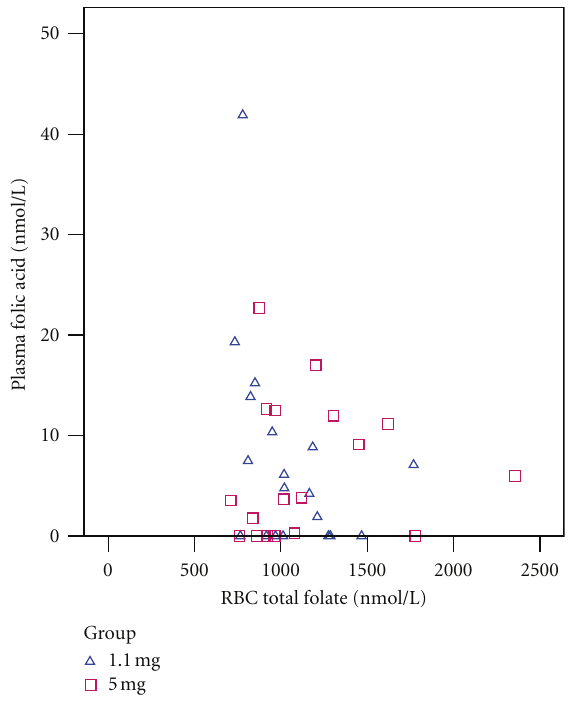
Figure 5: Relationship between plasma folic acid and RBC total folate. 1.1 mg group (triangles): Kendall’s τ b = − 0 . 36, P = 0 . 04. 5mg group (squares): Kendall’s τ b = 0 . 15, P = 0 . 39. Pooled data: Kendall’s τ b = − 0 . 068, P = 0 . 56.